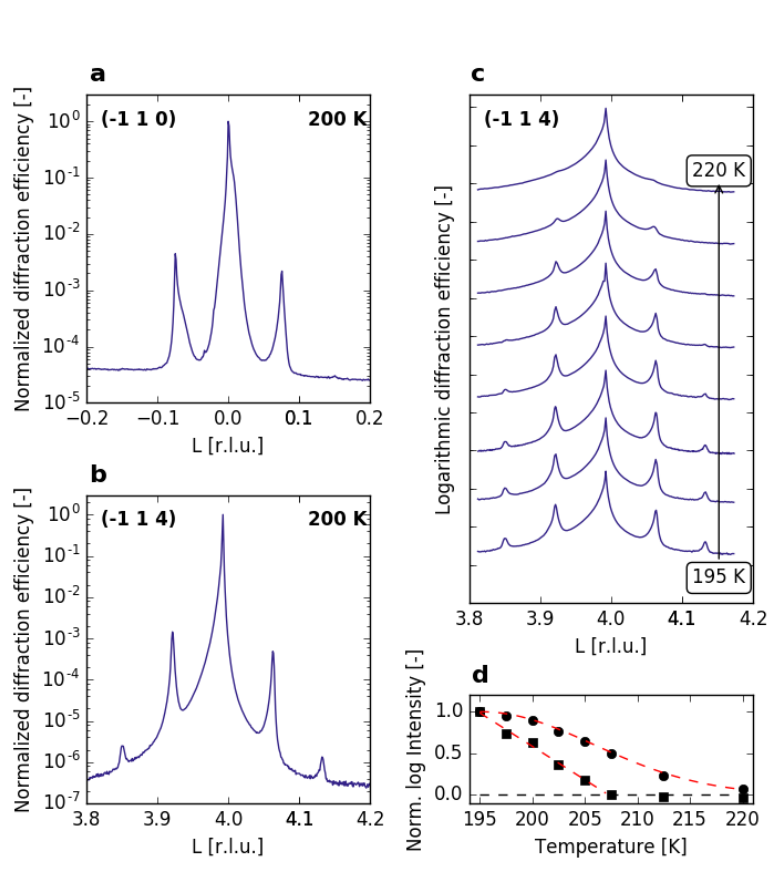
Figure 1. Bragg reflection intensities on a logarithmic scale with satellites, shown along the L-direction. ( a ) reciprocal scan of the ( − 1 1 0) reflection with its first-order satellites, ( b ) reciprocal scan of the ( − 1 1 4) reflection with two orders of satellite reflections. ( c ) temperature dependence of the ( − 1 1 4) reflection over the stability range of the incommensurate phase ( d ) normalized logarithmic intensity of the first, • , and second, (cid:4) , satellite order as a function of temperature, indicating the stability region